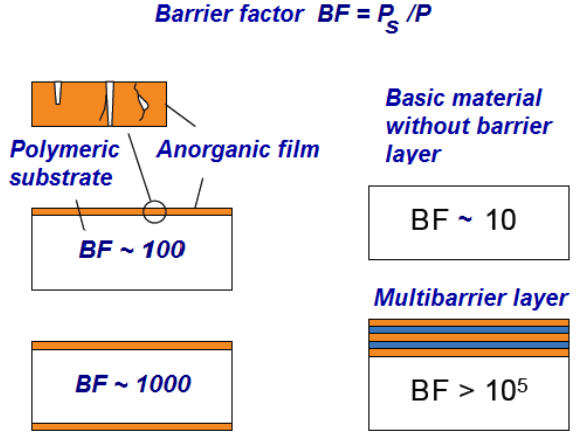
Figure 1. Influence of the barrier nanolayers arrangement on the protective properties of polymeric barrier materials.